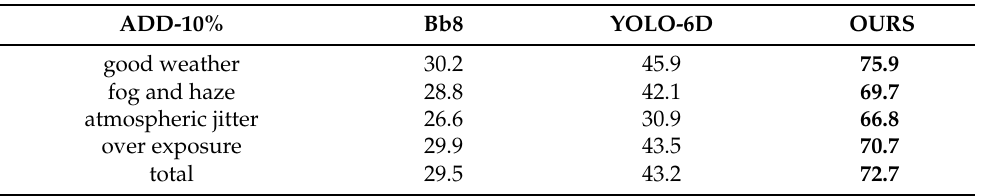
Table 3. Comparison with the state-of-the-art methods in terms of the ADD metric on APE dataset. Bold number indicates the best results.